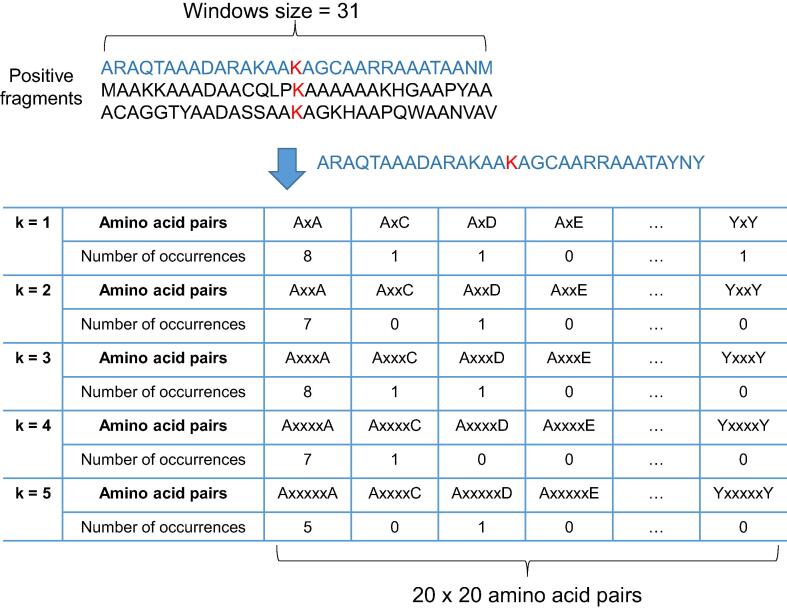
Composition of k-spaced amino acid pairs.Given 400 (20 × 20) amino acid pairs and five values for k (k = 1–5), there are 2000 attributes generated for the CKSAAP feature. The number of occurrences of each k-spaced amino acid pair is determined by sliding through the fragmented sequence one by one. CKSAAP, composition of k-spaced amino acid pair.